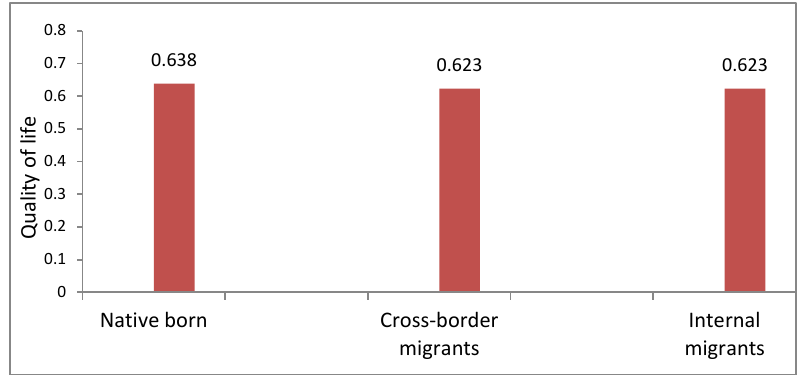
FIGURE 1: Quality of life scores of the different groups Source: Author’s calculations using GCRO data (GCRO,